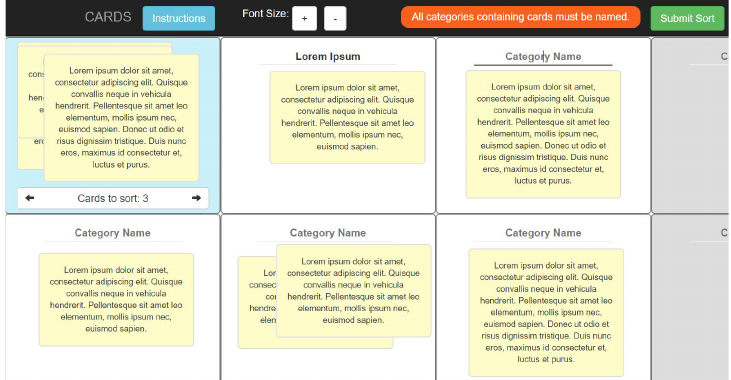
Fig. 2. CARDS Interface displaying example sort (using nonsensical placeholder